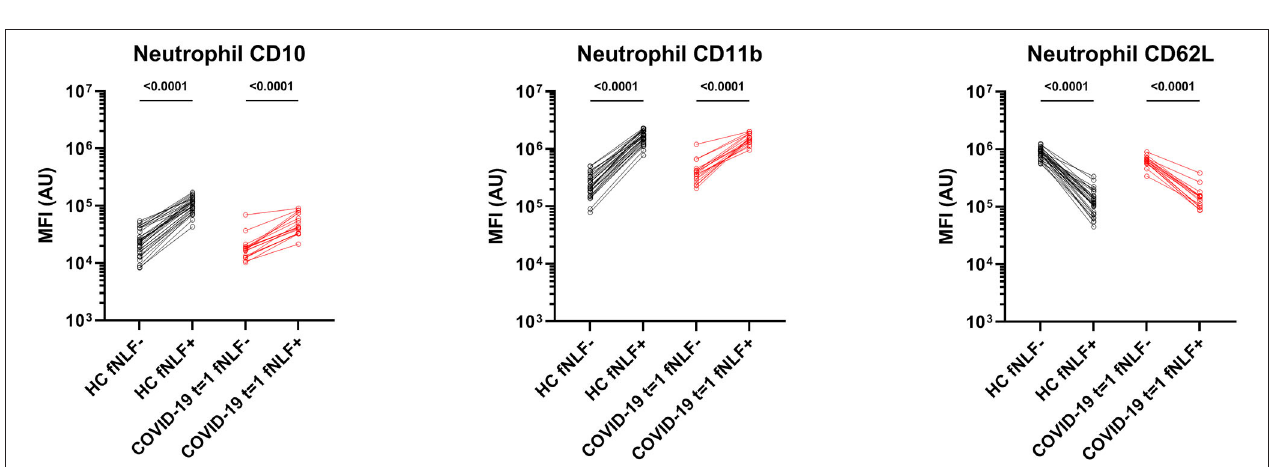
FIGURE 3 | Median fluorescence intensity (MFI) in arbitrary units (AU) for markers on mature neutrophils during ( t = 1) and 3 to 6 months after ( t = 2) active COVID-19 disease in primary care patients. Healthy controls (HC) are displayed as reference. fNLF-samples are measured in the absence of fNLF, whereas fNLF + samples are measured in the presence of the formylpeptide (10 µ M). Statistical significance was tested using the Mann-Whitney U Test for continuous variables and the Wilcoxon matched-pairs signed rank test for paired analyses.